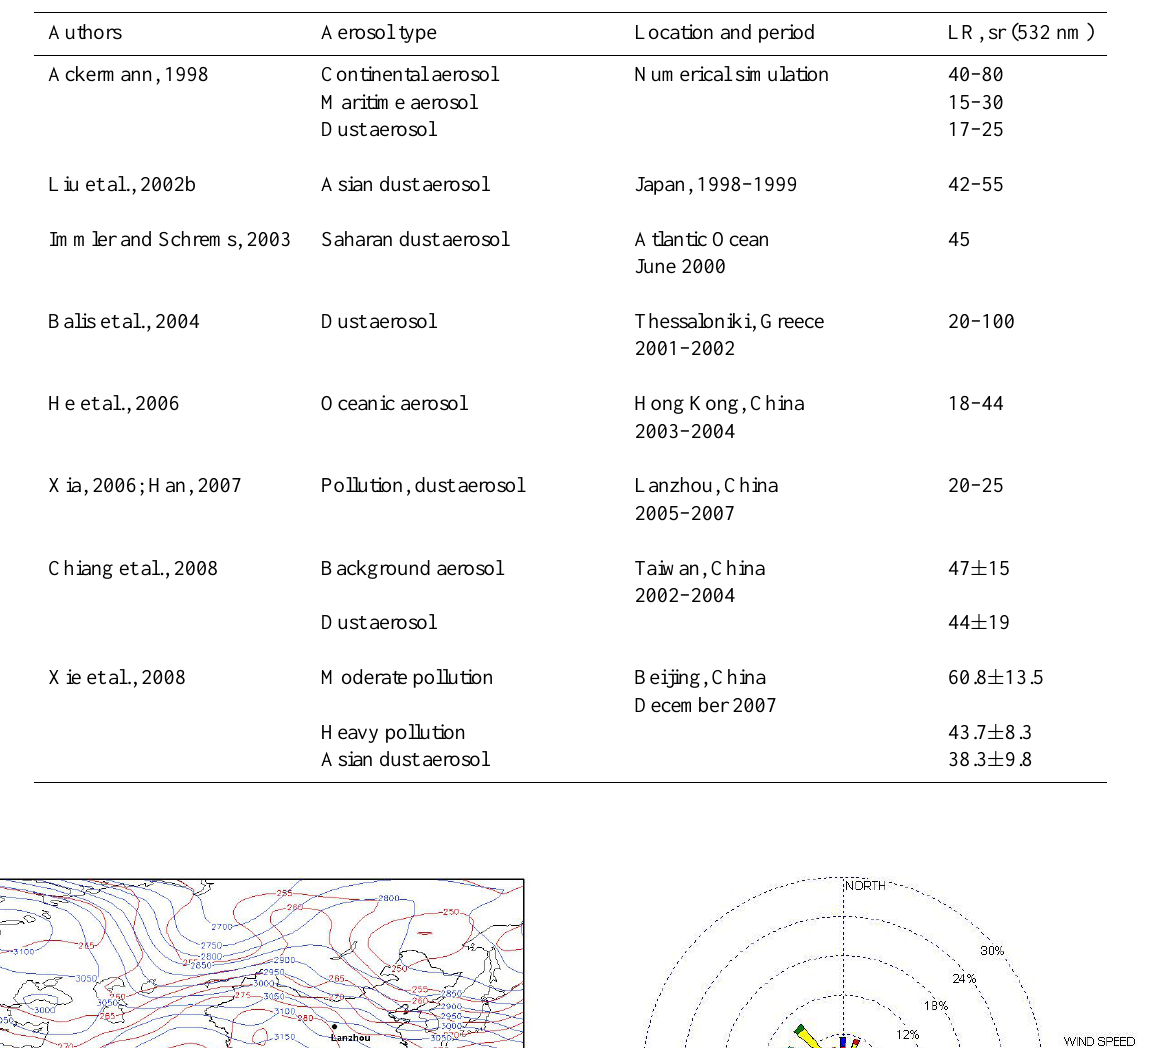
Table 2. Lidar ratio from observations and numerical simulation.